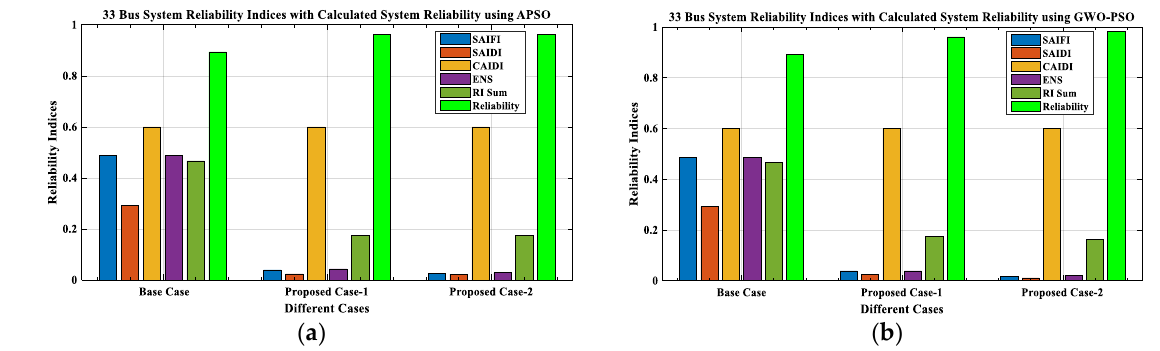
Figure 15. The fix, loss, and ENS cost for all the cases of 33-bus RDN; ( a ) APSO, ( b ) GWO-PSO.